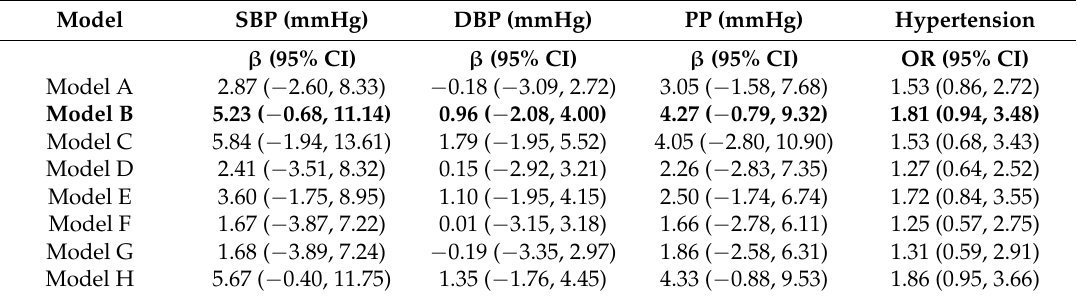
Table 2. Effect estimates for ln